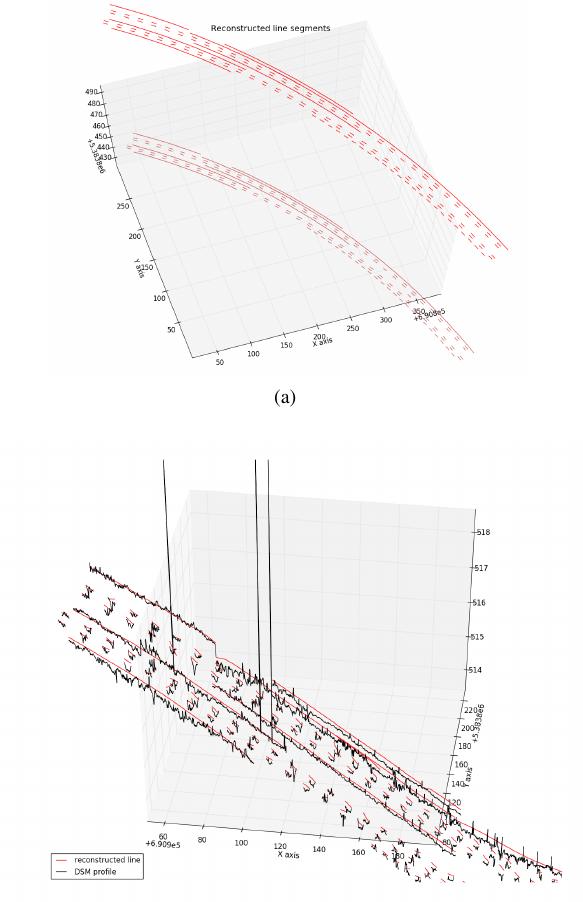
Figure 13. All the reconstructed lane-lines in the test area.